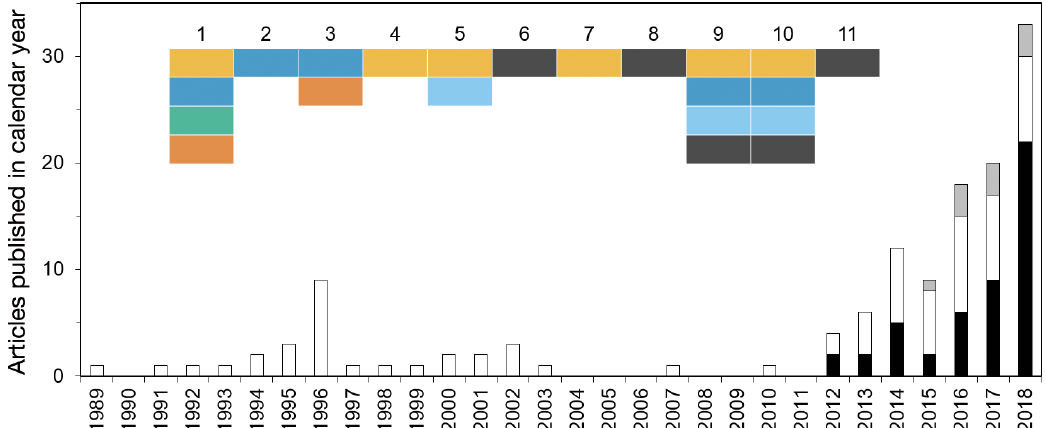
Fig. 1. Research effort over time on cleaner fish use in salmon aquaculture, measured by the number of journal articles or tech- nical reports published in each calendar year. Bars are colour-coded by the cleaner fish species studied: black = lumpfish, white = wrasse, grey = both. Studies that tested the efficacy of cleaner fish for lice removal are also listed in chronological or- der (inset): (1) Bjordal (1991); (2) Treasurer (1994); (3) Tully et al. (1996); (4) Treasurer (2013); (5) Skiftesvik et al. (2013); (6) Ims - land et al. (2014a,b, 2015); (7) Leclercq et al. (2014); (8) Imsland et al. (2016); (9) Skiftesvik et al. (2017); (10) Skiftesvik et al. (2018); (11) Imsland et al. (2018). The coloured blocks indicate the species used in each study: black = lumpfish, yellow = bal- lan wrasse, light blue = corkwing wrasse, green = cuckoo wrasse, dark blue = goldsinny wrasse, orange = rock cook